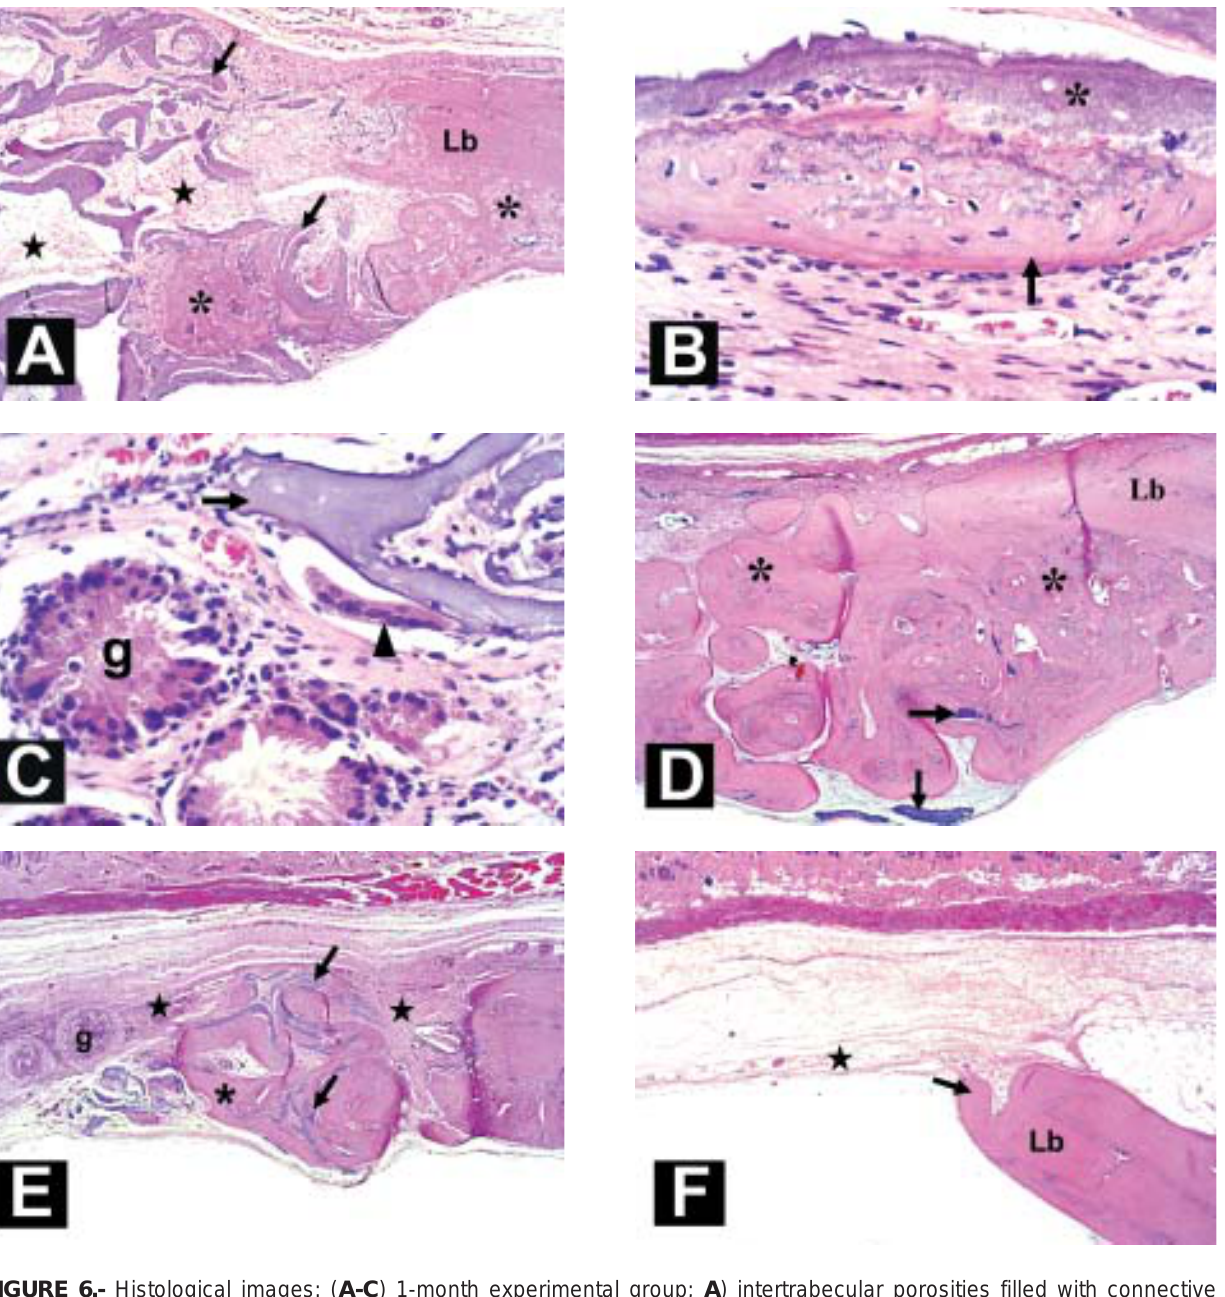
FIGURE 6.- Histological images: ( A-C ) 1-month experimental group; A ) intertrabecular porosities filled with connective tissue (stars) and newly formed bone tissue (asterisks) in the lesion border (Lb) and associated with the trabecular surface of matrix (arrow); B) detail of bone tissue (arrow) associated with the matrix surface (asterisk); and C ) giant multinucleated cells (arrowhead) in the matrix (arrow) surface and areas of foreign body-type granuloma (g). ( D-E ) 3-month experimental groups; D ) defect filled with great amount of neoformed bone tissue (asterisk) and fragments of matrix (arrows); and E) defect filled with small islets of neoformed bone (asterisk) and fibrous connective tissue (stars) showing foreign body-type granulomas (g). ( F ) 6-month control group, defect filled with connective tissue (star) and exhibiting small bone formation (asterisk) in the border lesion (Lb). Hematoxilin-eosin, 34x and 340x